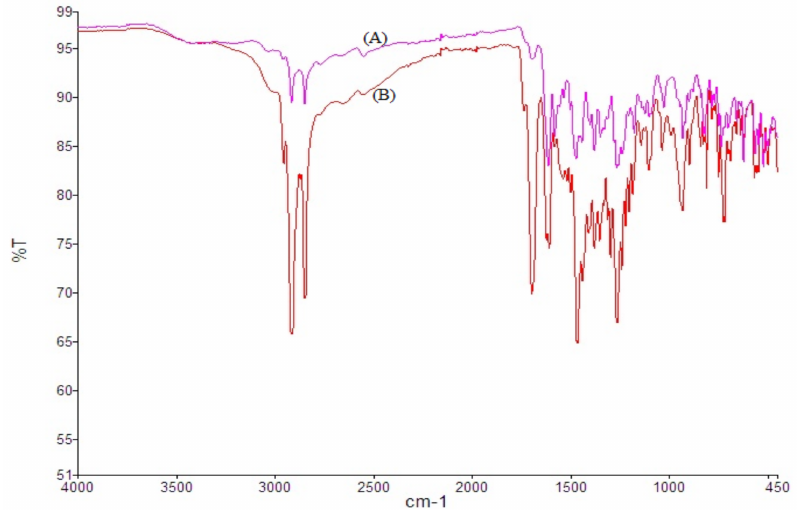
Figure 3. FT-IR spectra of unprocessed NOR ( A ) and processed NOR-5 ( B